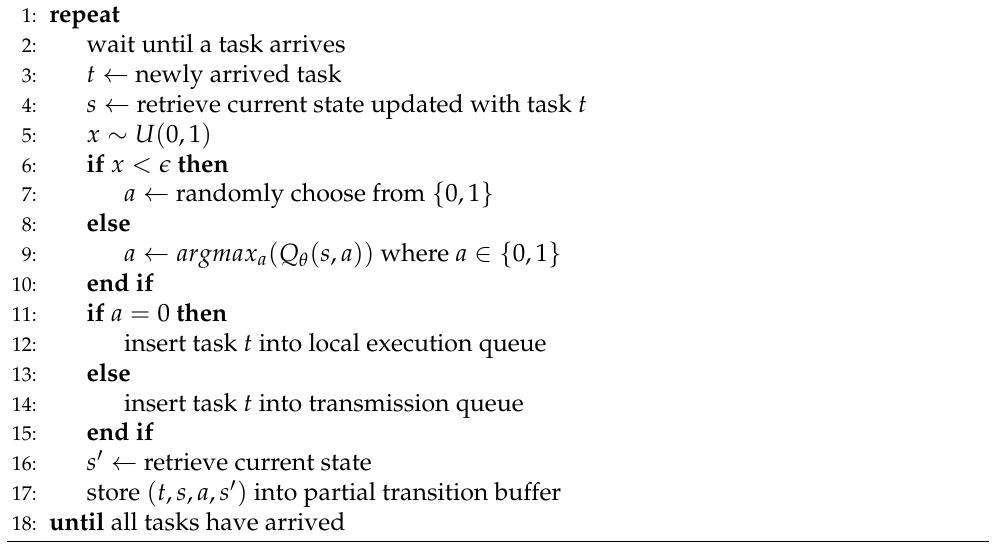
Algorithm 4 Task arrival algorithm for mobile